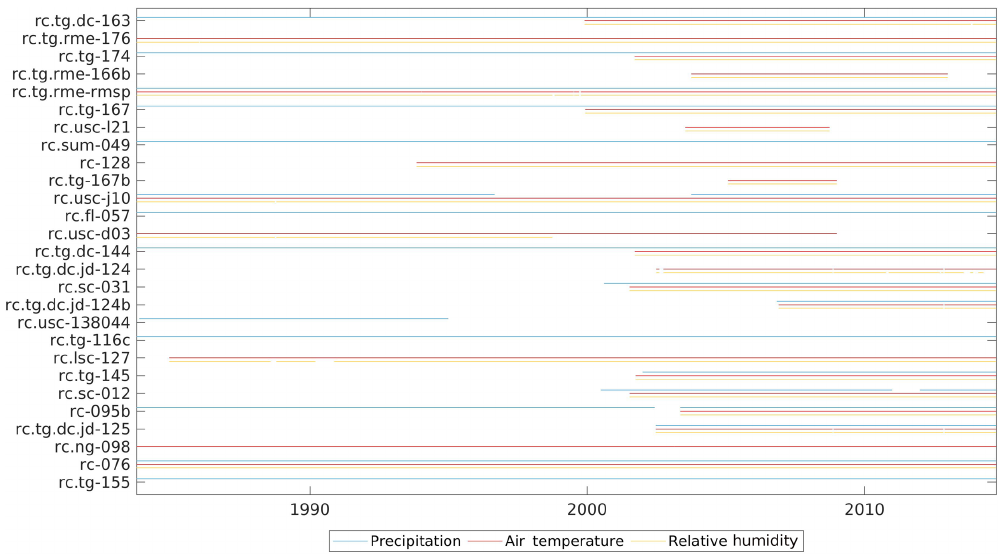
Figure 2. Measurement sites and the corresponding time periods that data from that site were used in the construction of the spatial data.